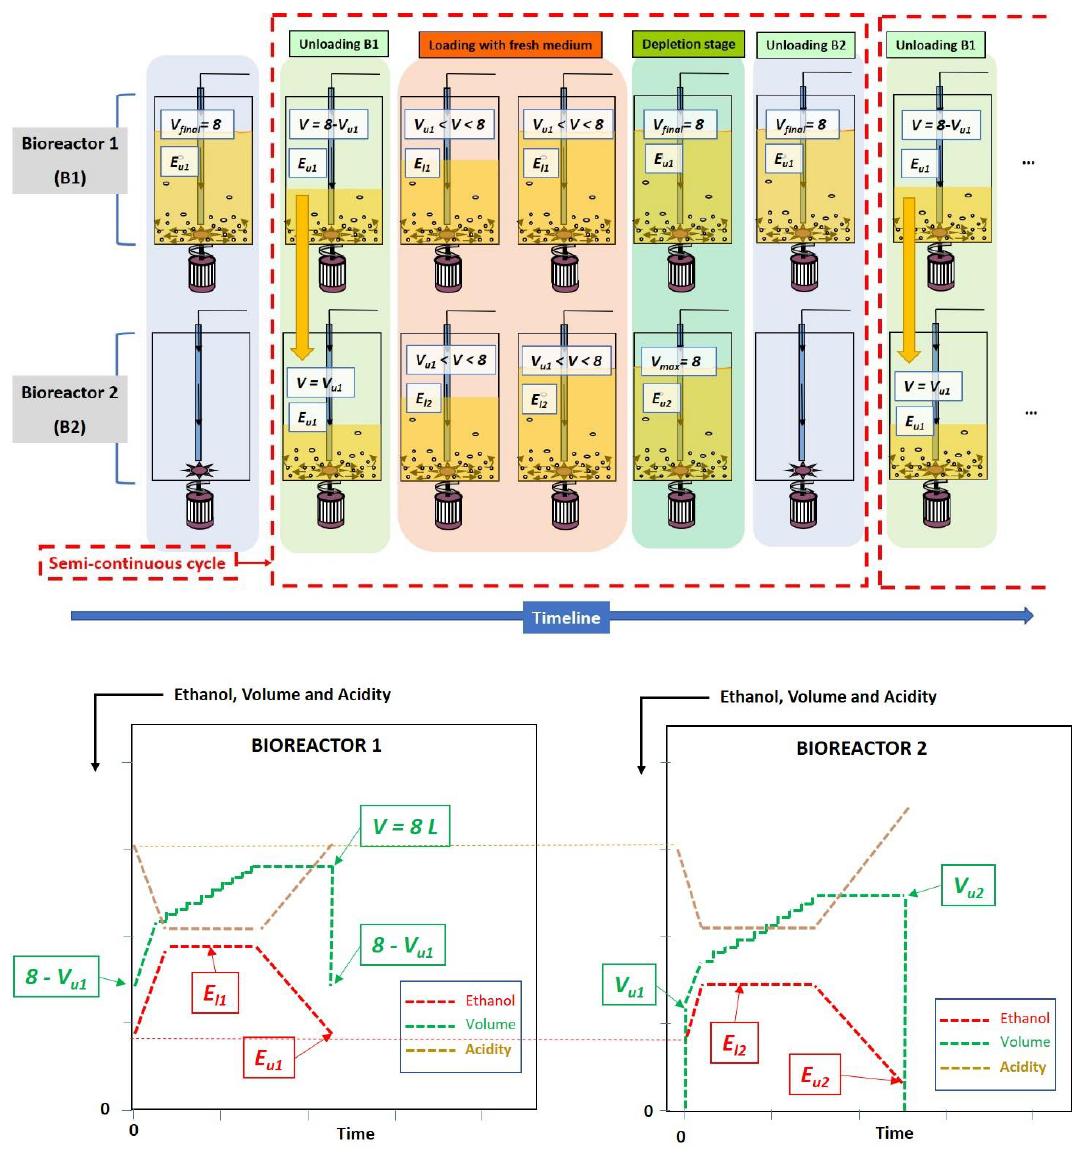
Figure 2. Scheme of two serial bioreactors operating in a repeated semi-continuous mode as well as example of profiles for the volume of medium, ethanol concentration and acetic acid concentration in each bioreactor. 𝐸 𝑢1 and 𝐸 𝑢2 are the ethanol concentrations at the time the first and second bioreactor, respectively, are unloaded; 𝐸 𝑙1 and 𝐸 𝑙2 the ethanol concentrations during loading of the first and second bioreactor, respectively; and 𝑉 𝑢1 and 𝑉 𝑢2 the volumes of medium unloaded from the first and second, respectively.